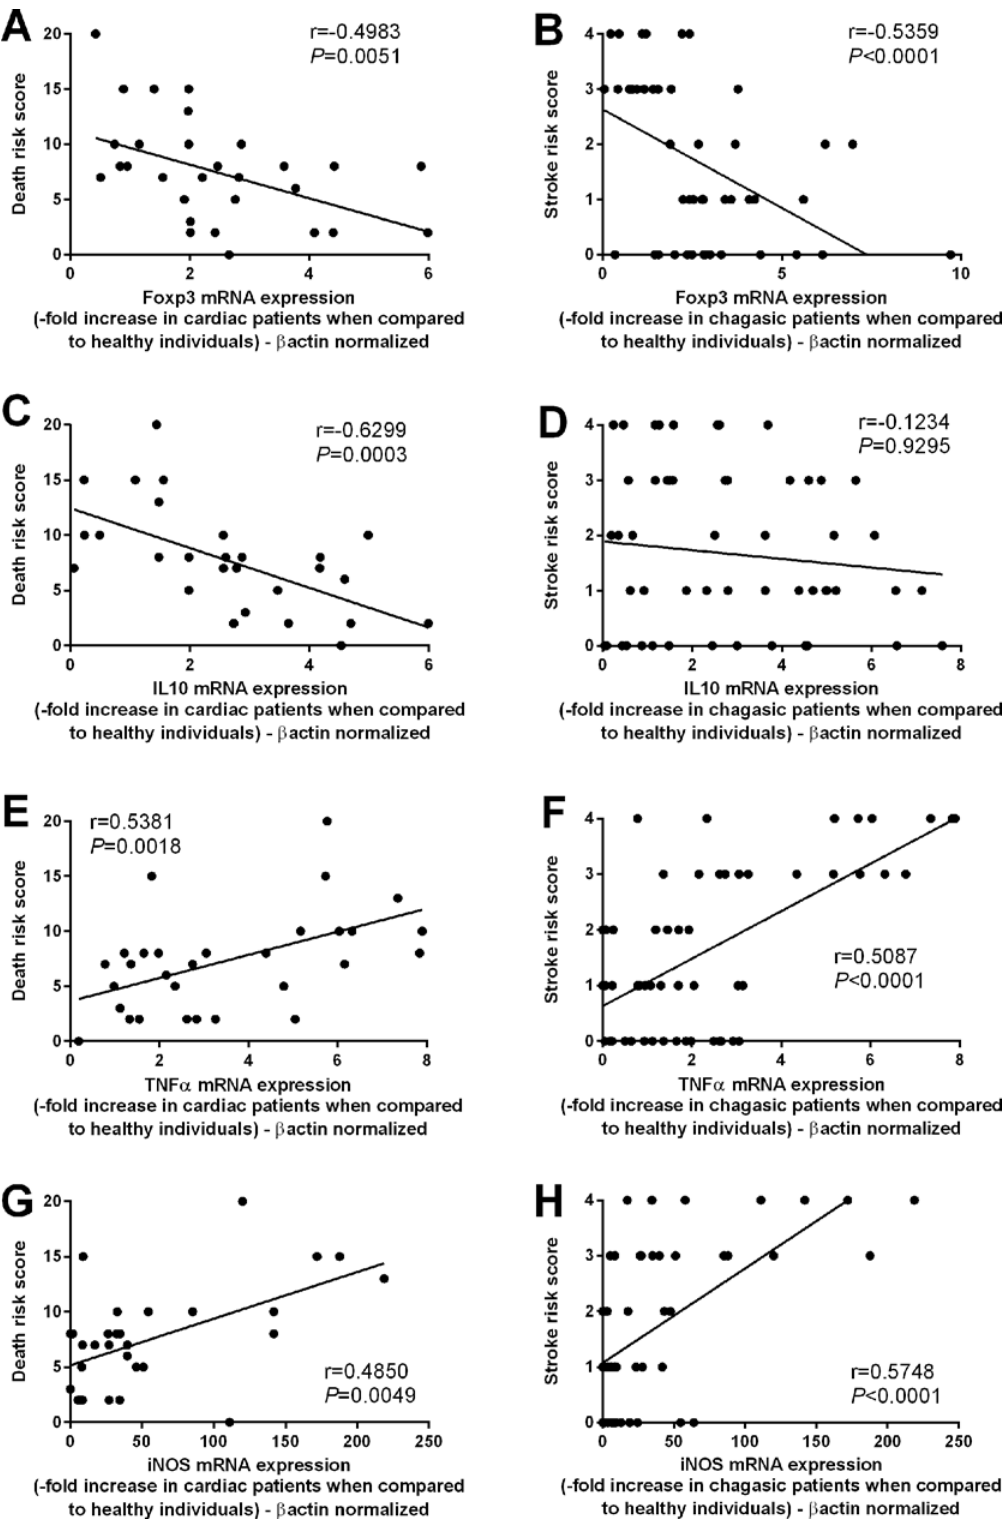
Fig 5. High TNF- α , iNOS and low Foxp3 expression are correlated with the risks of death and stroke. The mRNA expression levels of Foxp3 ( A and B ), IL-10 ( C and D ), TNF- α ( E and F ) and iNOS ( G and H ) were determined by real-time PCR of peripheral blood mononuclear cells from chagasic